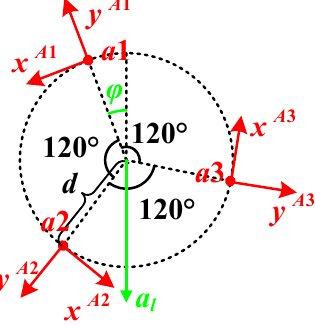
Figure 3. Distribution of the accelerometers.